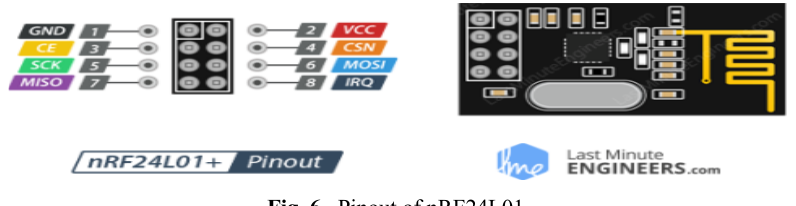
Fig. 6. Pinout of